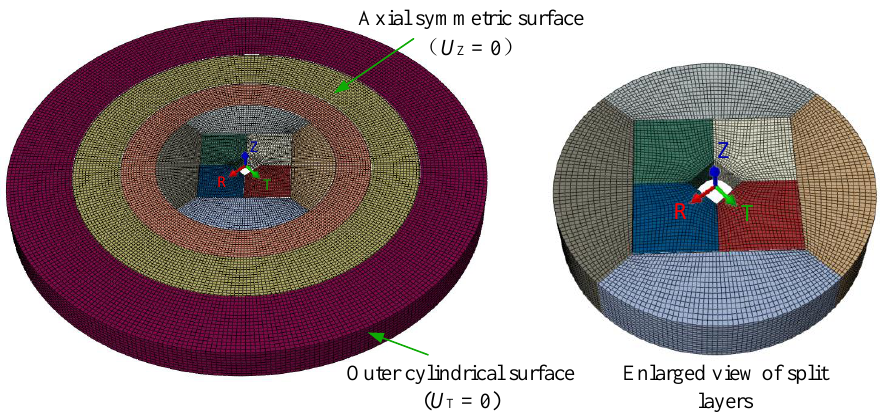
Figure 3. Finite element model of high-pressure die (1/2).